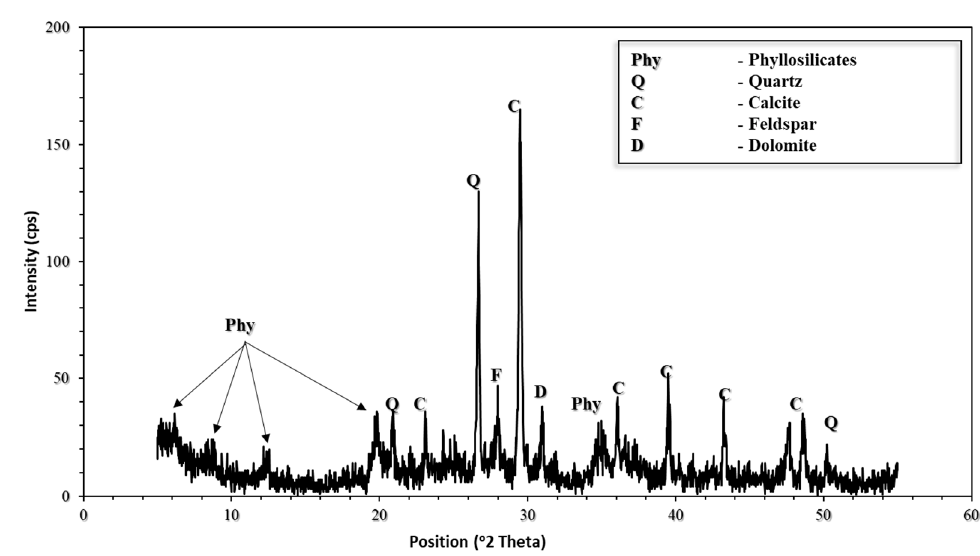
Figure 2. X-ray di ff raction pattern of studied clay Figure 2. X-ray diffraction pattern of studied clay sample.